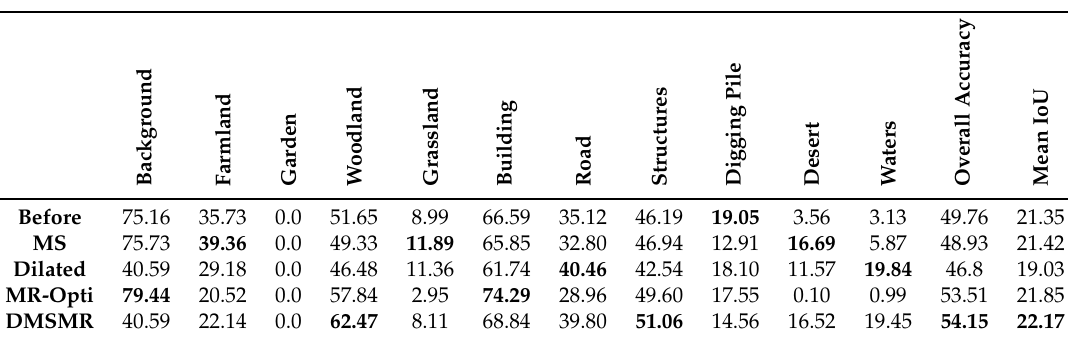
Figure 8. Accuracy analysis with respect to boundary on EvLab-SS dataset. ( a ) Visualization of trimap for EvLab-SS dataset. Top-left: source patch. Top-right: ground truth. Bottom-left: trimap with one pixel band width. Bottom-right: trimap with three pixels band width. ( b ) Pixel mIoU with respect to band width around object boundaries. We measure the relationship for our model before and after employing the multi-scale ( MS ), dilated convolution ( Dilated ), single stream Manifold Ranking ( MR-Opti ) and joint strategies ( DMSMR ) on the EvLab-SS dataset. Table 5. Quantitative evaluation of the semantic segmentation results on the EvLab-SS dataset. The proposed DMSMR approach outperforms the methods that employ only one